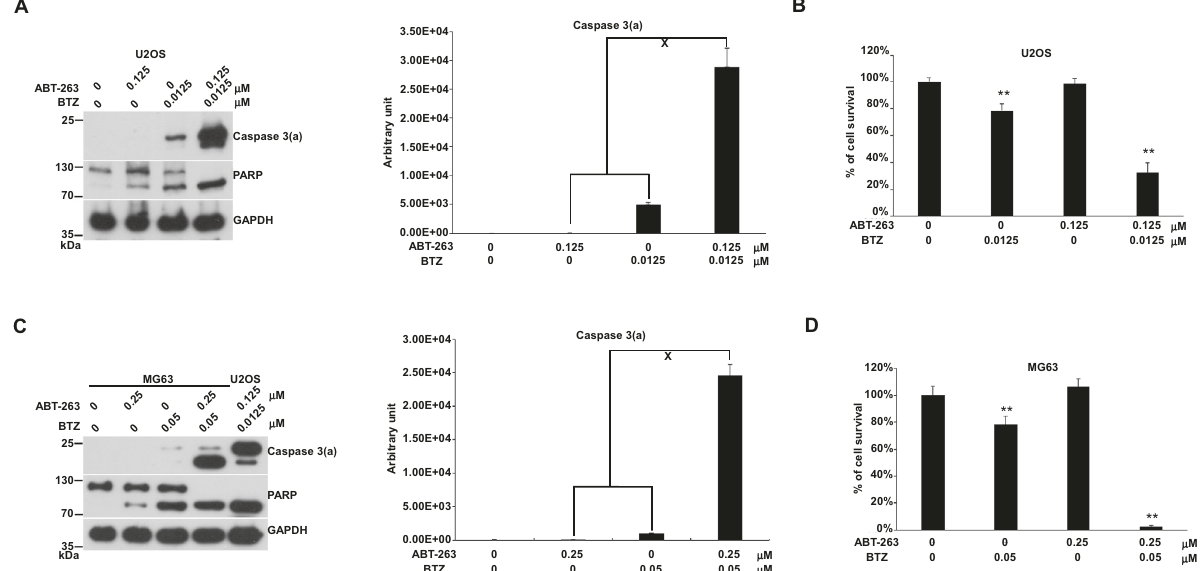
Fig. 5 Effects of the combination of BTZ with ABT-263 on apoptosis in U2OS and MG63 cells. Cells were incubated with ABT-263, BTZ, or a combination of both in 10-cm plates or 96-well plates for 24 h and harvested for western blotting or cell survival assay, respectively. The immunoblot images of caspase 3(a) and PARP and cell death results were shown. GAPDH served as a loading control. The immunoblot images of caspase 3(a) normalized to GAPDH in cells were quantitated as shown. The “ x ” indicated a synergistic outcome. The percentages of cell survival normalized to the cells without compound treatment were shown (** P < 0.01). The immune blots were cropped from different parts of the same gels and visualized by ECL with various exposure conditions dependent on the activity of antibodies. Representative blots from triplicate experiments were shown. A Immunoblot image of U2OS. B U2OS cell survival. C Immunoblot image of MG63. D MG63 cell survival.